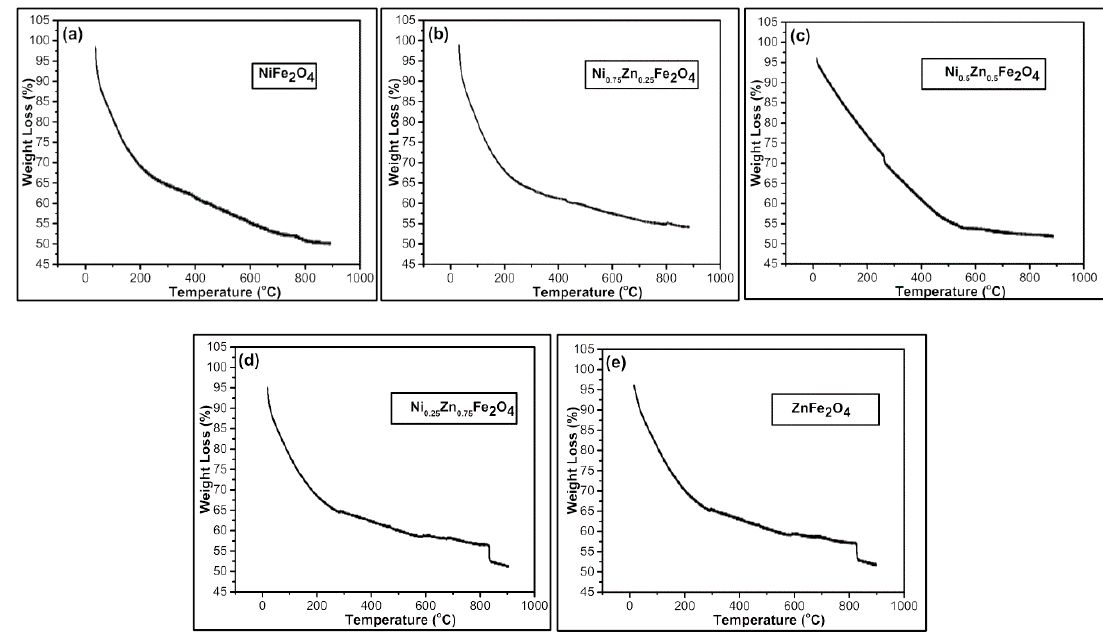
Figure 4. TGA analysis of Ni 1 − x Zn x Fe 2 O 4 ( a ) x = 0, ( b ) x = 0.25, ( c ) x = 0.5, ( d ) x = 0.75, ( e ) x = 1.